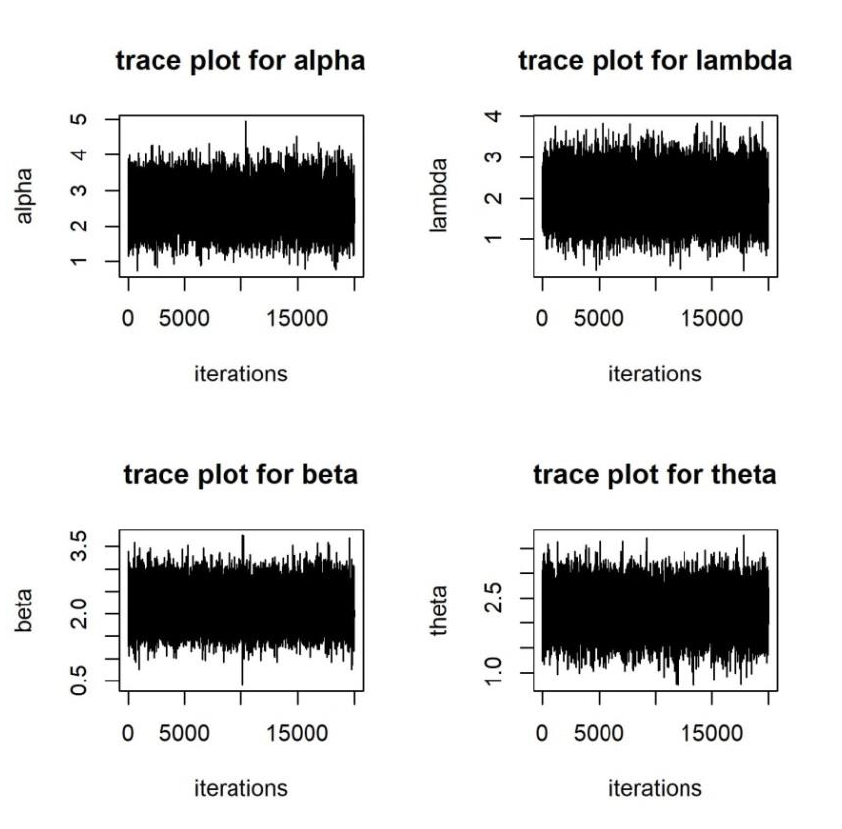
Figure 1. Trace plots for 𝛼, 𝜆, 𝛽, 𝜃